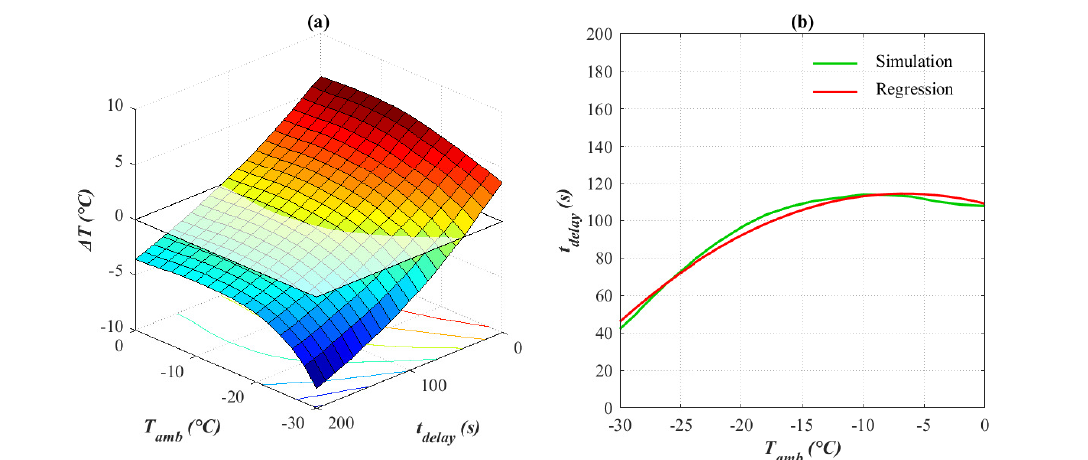
Figure 9. ( a ) Dependencies of the temperature difference ( ∆ T ) between the layers on the duration of the idle period and ambient temperature at the end of pre-heating. ( b ) Relationships between the duration of idle period and the ambient temperature to achieve ∆ T ≈ 0 ◦ C at the end of pre-heating.